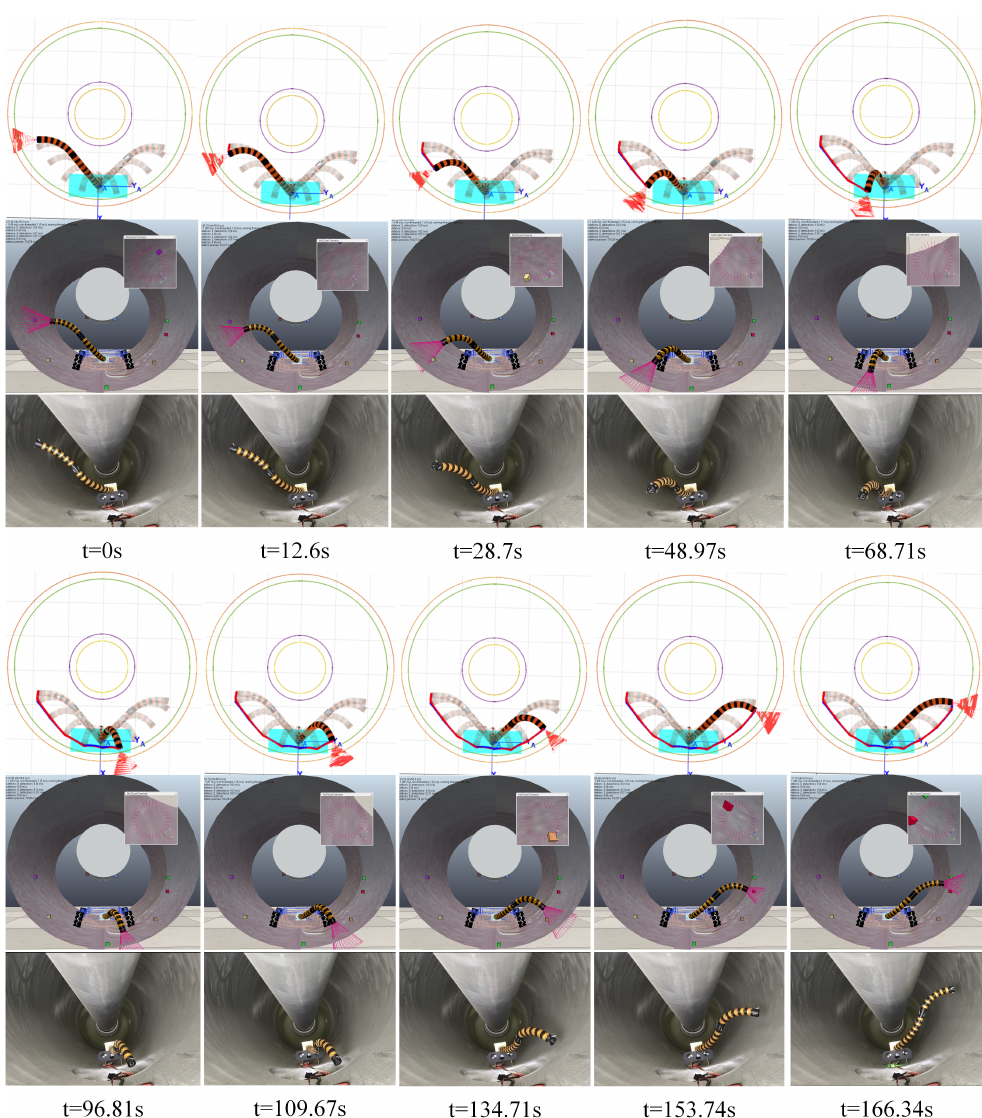
Figure 10. Comparison of the motion sequence obtained by Matlab ( top ), CoppeliaSim ( middle ), and simulation and prototype experiment ( bottom ).